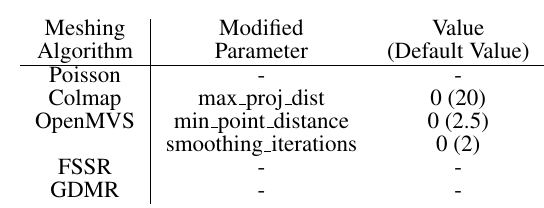
Table 3. Quantitative evaluation of the proposed pipeline with different state-of-the-art surface reconstruction algorithms. The reconstructed mesh vertices are used as surface representation to compute the metrics. See Table 2 for a description of the different algorithms and metrics. As baseline for our comparison we use the vertices of the fused point clouds computed with VisSat (Zhang et al., 2019) and MVE (Goesele et al., 2007). The top three results are highlighted with green (first), blue (second) and red (third).